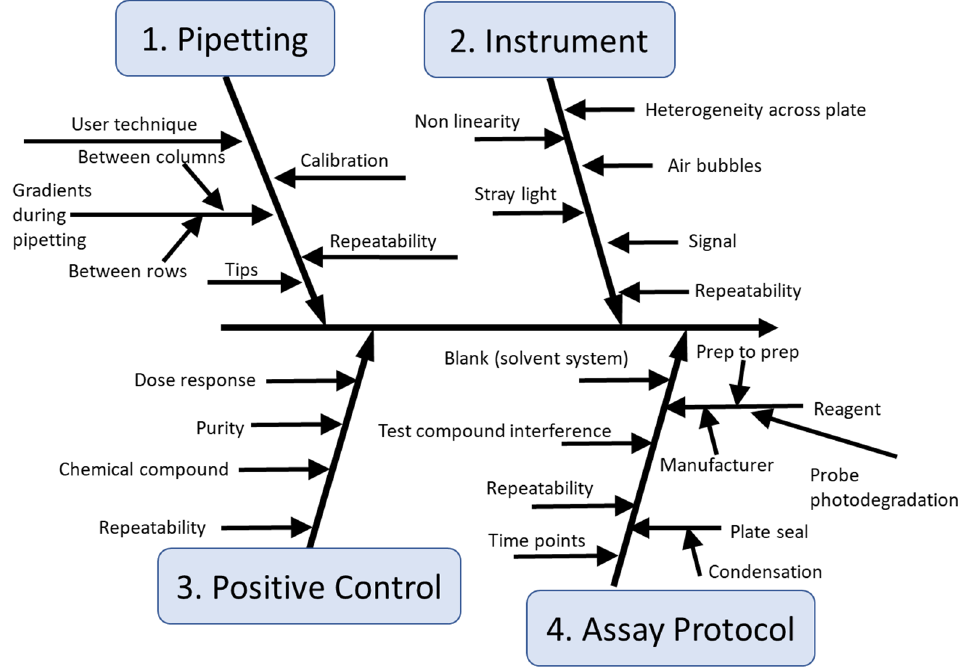
Figure 4. Cause-and-effect analysis of the EASA method. The four main branches indicate factors that are expected to have the greatest potential to cause variability in assay results.